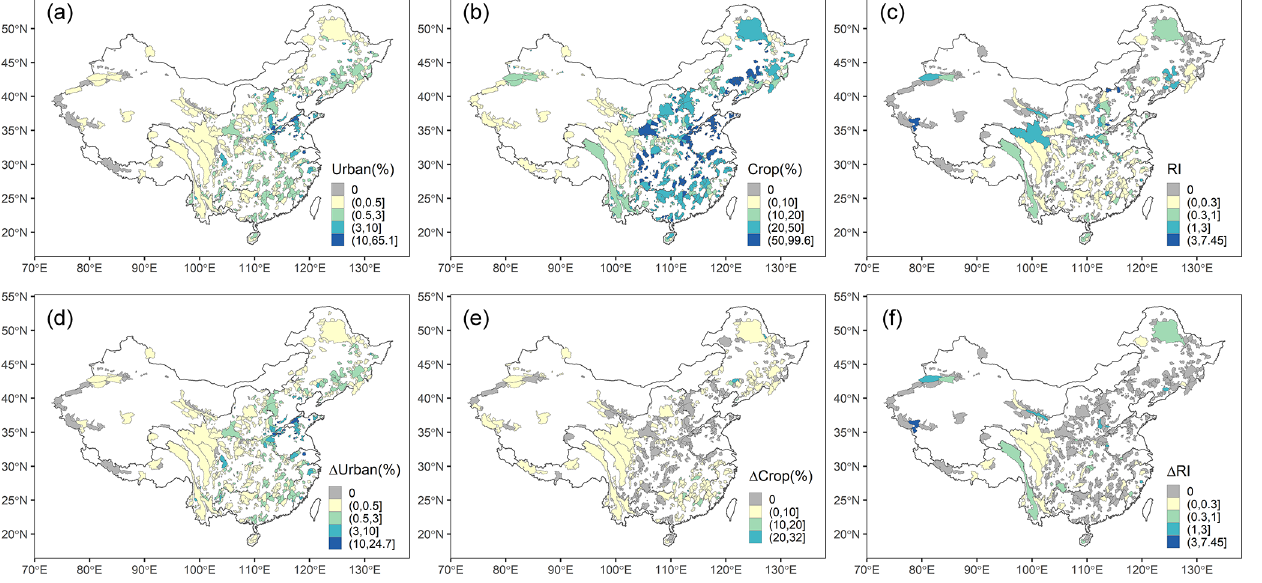
Figure 3. Spatial distribution of catchment characteristics in 757 independent catchments. (a) Urban percentages (Urban), (b) cropland percentages (Crop), and (c) reservoir indexes (RIs) in their last years with available flood data. The changes in (d) urban areas ( (cid:49) Urban), (e) cropland areas ( (cid:49) Crop), and (f) reservoir indexes ( (cid:49) RI) in